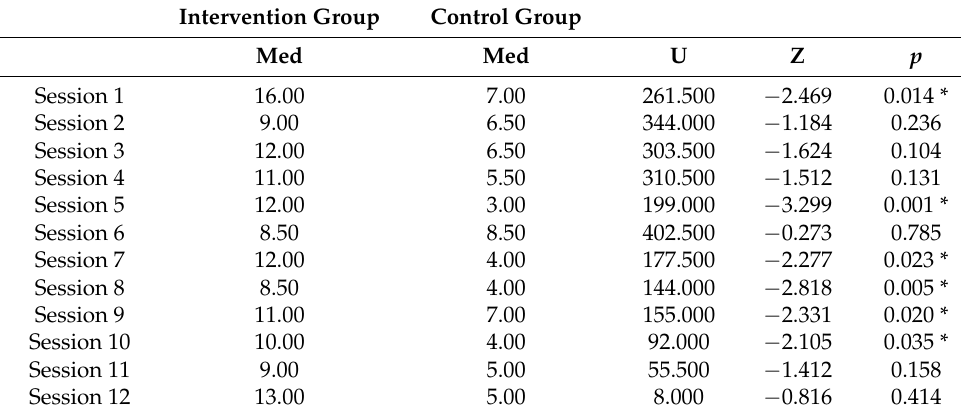
Table 4. Mean pre- and post-intervention differences in heart rate behavior during 12 progressive muscle relaxation sessions for athletes in the intervention and control groups, and p -value resulting from the comparison using the Mann–Whitney test. Intervention Group